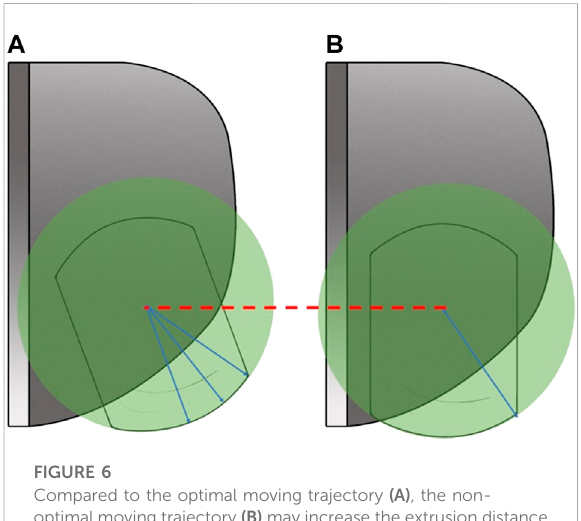
FIGURE 6 Compared to the optimal moving trajectory (A) , the non- optimal moving trajectory (B) may increase the extrusion distance and area of the meniscus